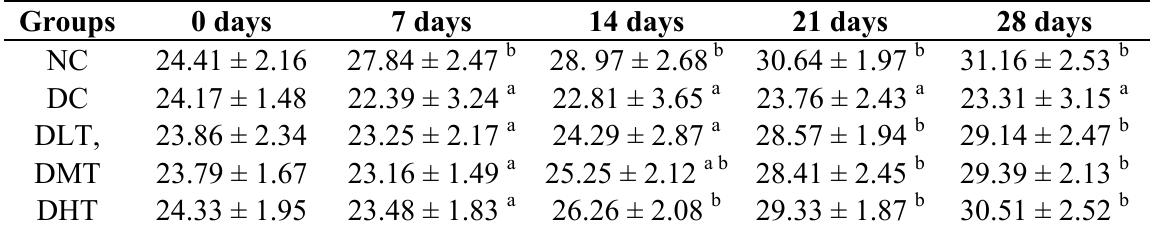
Table 1. Effect of salidroside administration on body weight in